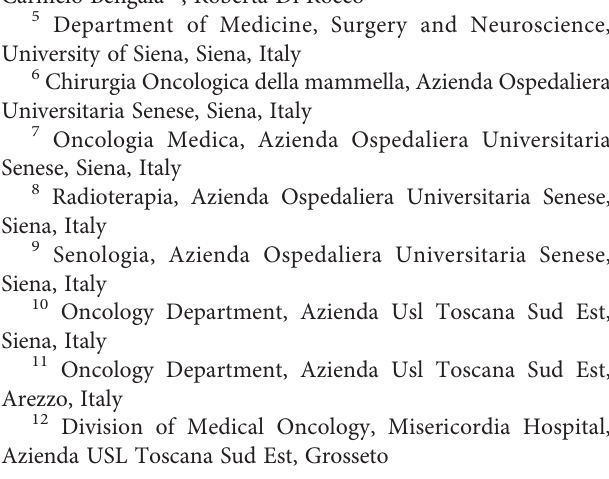
Supplementary Figure 1 | MLPA results for BRCA1 gene. MLPA results for BRCA1 gene of a patient (#1369/19) with familial BC. MLPA size probes for each exon (top) and genomic position (bottom), are given on the X axis. Calculated probe ratios of test sample normalized to the reference samples is given on the Y axis. Probe ratios are indicated by the dots. Black dots indicate probes within the con fi dence interval (ratio 0.7 to 1.3 by default). Red dot reveals a heterozygous deletion, probe ratio 0.5, in the test sample. Supplementary Figure 2 | Pedigrees of patients carrying pathogenic variants in BRCA1-2 . Pedigree of patients #3027/20, 352/20, 5632/20, 5647/19, 2734/20, 1568/20, 937/20, 1946/20, 2523/20, 1356/20, 1354/20, and 1369/19. The gene and their variants are reported below the symbol of each proband. The arrows indicate the proband from each family. The black symbols indicate “ HBOC- spectrum phenotypes ” while striped symbols indicate “ other neoplasms. ” Abbreviations as in Figure 1 . Supplementary Table 1 | Pathogenic variants found in HBOC genes. HGVS, Human Genome Variation Society (http://www.hgvs.org); ClinVar, Clinical Variation database (https://www.ncbi.nlm.nih.gov/clinvar/); MAF, Minor Allele Frequency; CADD, Combined Annotation Dependent Depletion; NA, non applicable; NR, non reported.